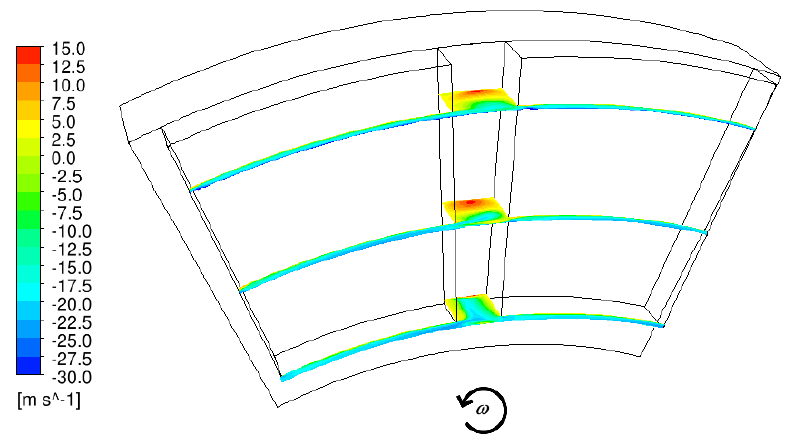
Figure 4. Relative tangential velocity contour across the air-channel for different radii at G = 0.0135, Re = 1.06 × 10 5 , α m = 0.8, and L = 0.0540. Positive values indicate a relative flow in the direction of the rotation.